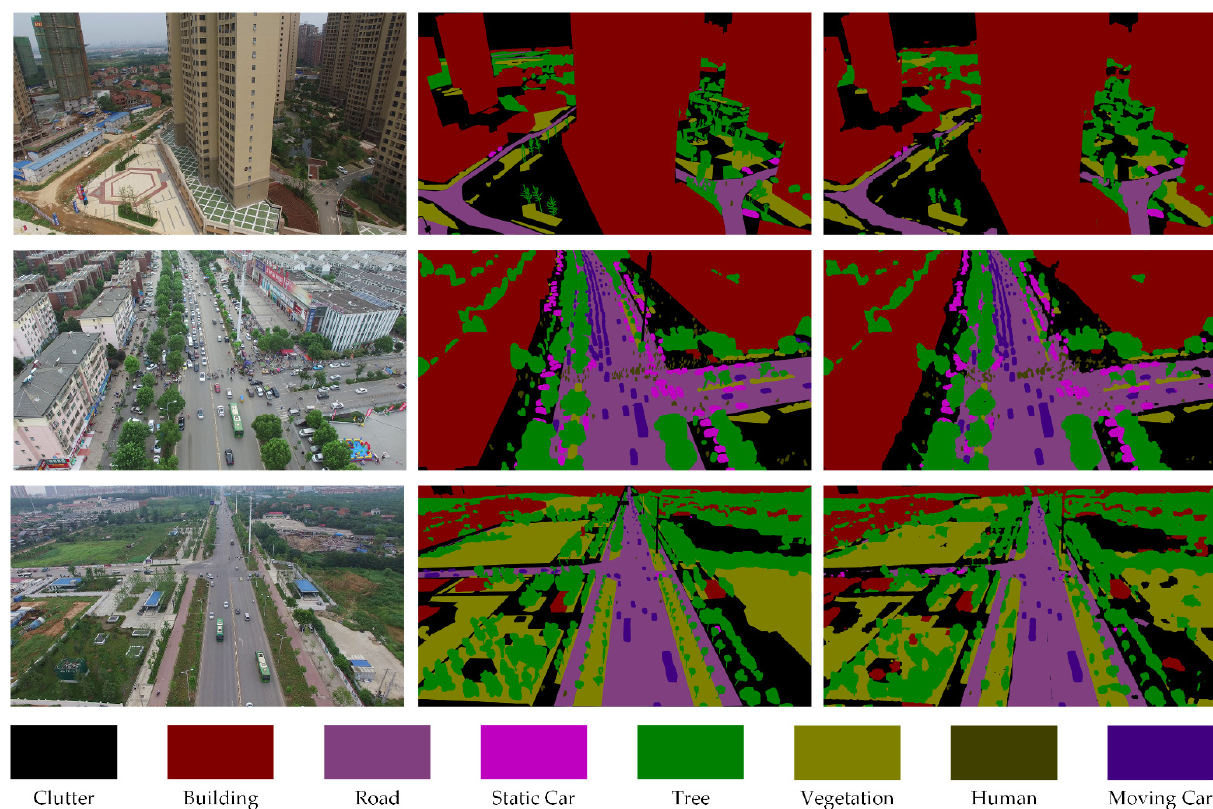
Figure 10. The experimental results on the UAVid validation set. The first column illustrates the input RGB images; the second column depicts the ground reference, and the third column shows the predictions of our BANet.